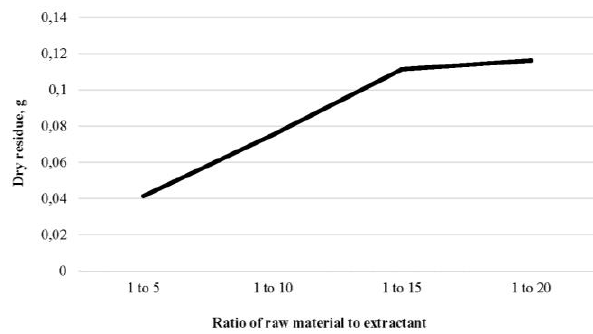
Fig. 2. Determination of optimal raw material to extract- ant